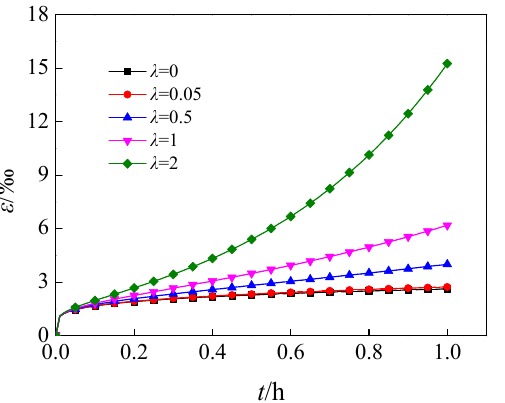
Figure 10. Curves of the creep properties of the rock mass under various damage.